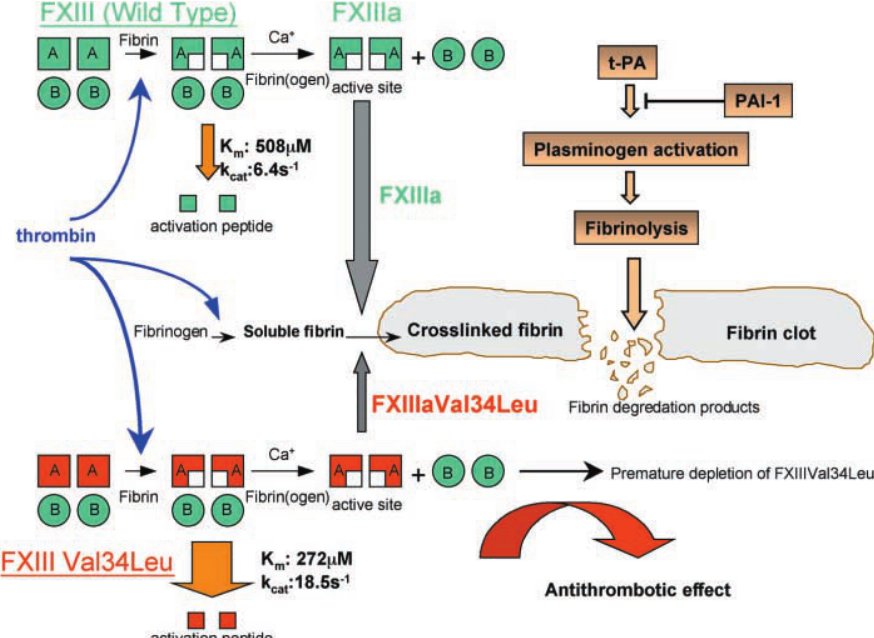
FXIII pathway and possible effects on clot for- mation by genotype. After activation by throm- bin, a small activation peptide is cleaved from the A-subunit (FXIII wild type: shown in green, FXIIIVal34Leu: shown in red). In a further step, the FXIII tetramer dissociates by separating the B subunits (carrier protein) from both A sub- units. The active site of FXIII is now ready for the crosslinking reaction. The rate of FXIII acti- vation and therefore cleavage of the activation peptide is influenced by FXIII genotype with an increase in k cat but a decrease in K m in posses- sion of the Leu allele (orange arrows). These changes lead to premature depletion of FXIII- Val34Leu and a decrease in cross-linking reac- tion (grey arrows). Fibrinogen is activated by thrombin to form soluble fibrin. In a further step, soluble fibrin is cross-linked by FXIII to form a stable, insoluble fibrin network. Plas- minogen activation by tissue plasminogen activator (t-PA) and therefore initiation of fibri- nolysis is inhibited by plasminogen activator inhibitor-1 (PAI-1), a strong marker of insulin